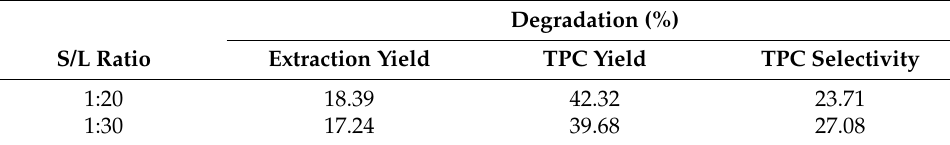
Table 2. Time-related degradation: percent losses of yield and TPC for re-irradiated samples (from 30 min to 45